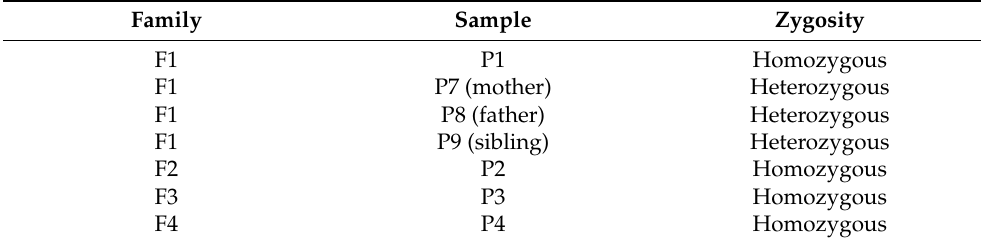
Table 1. Zygosity of individuals for the UFM1 :c-155_-153delTCA mutation. P7, P8, and P9 were tested in frames of cascade testing. Only the parents of P1 were available for testing. All patients are of Roma descent.